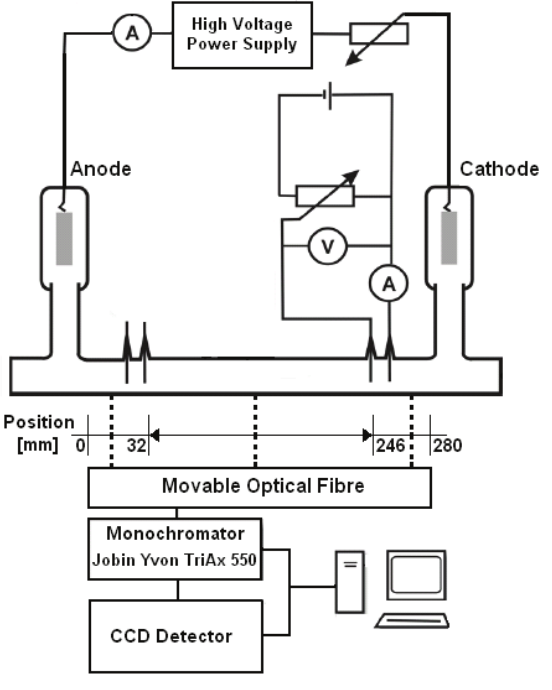
Figure 1: Experimental setup for both electric and spectroscopic